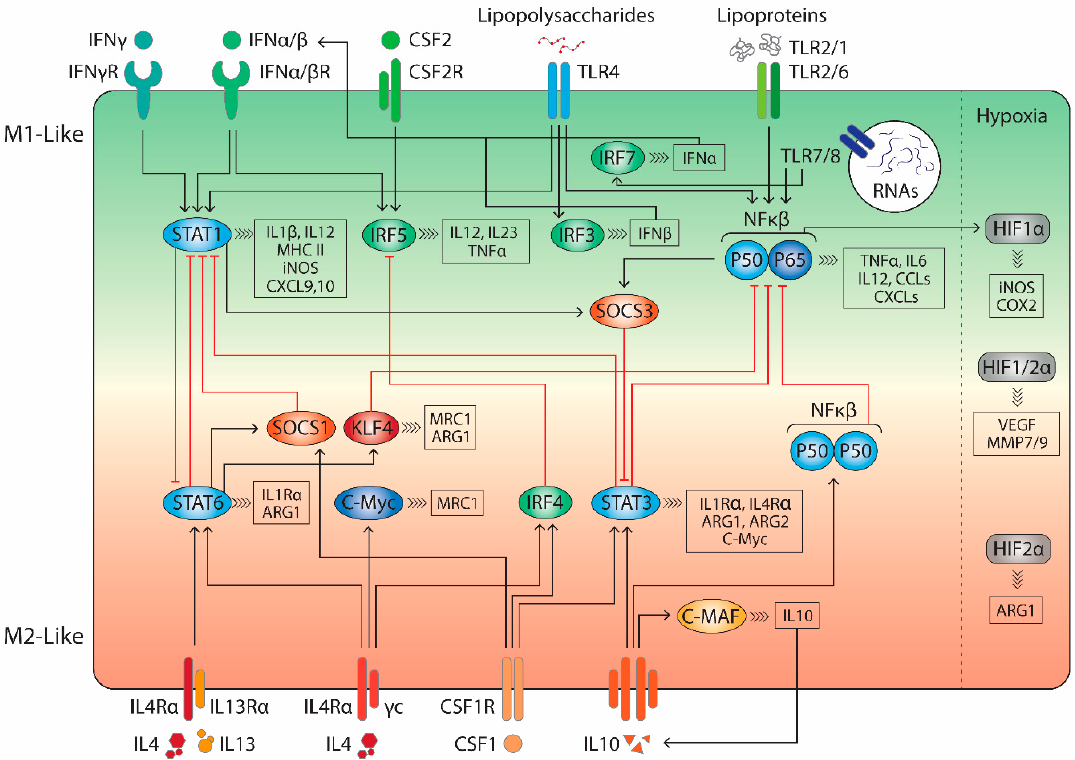
Figure 2. Schematic representation of the key signalling pathways driving macrophage polarisation. M1 stimuli as IFN γ , bacterial lipoproteins or lipopolysaccharides induce IRF3, IRF5, IRF7, STAT1 and P50-P65 NF κβ signalling leading to a proinflammatory response. In contrast, M2 stimuli as IL4, IL10 and IL13 activate IRF4, STAT3, STAT6 and P50-P50 NF κβ signalling resulting in anti-inflammatory gene expression and tumour progression. The crosstalk between these regulatory pathways determines the exact outcome of macrophage activity.